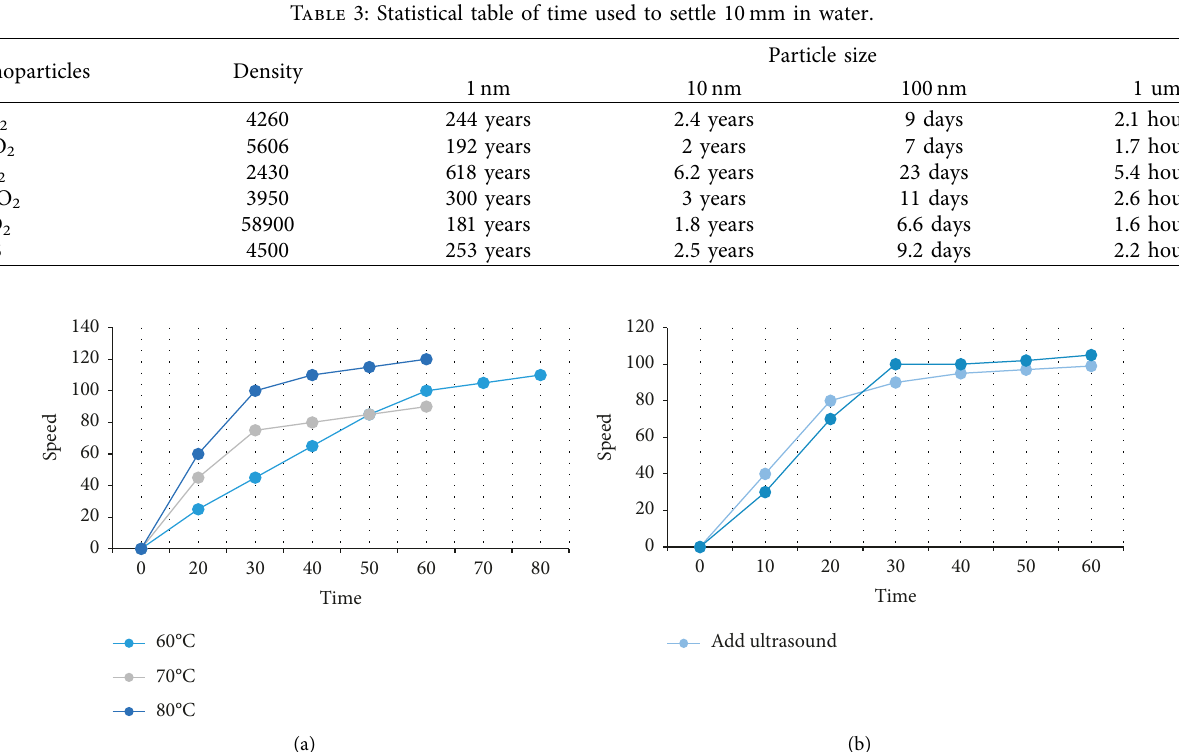
Figure 10: The effect of temperature on the deposition rate and the effect of adding ultrasonic waves on the deposition